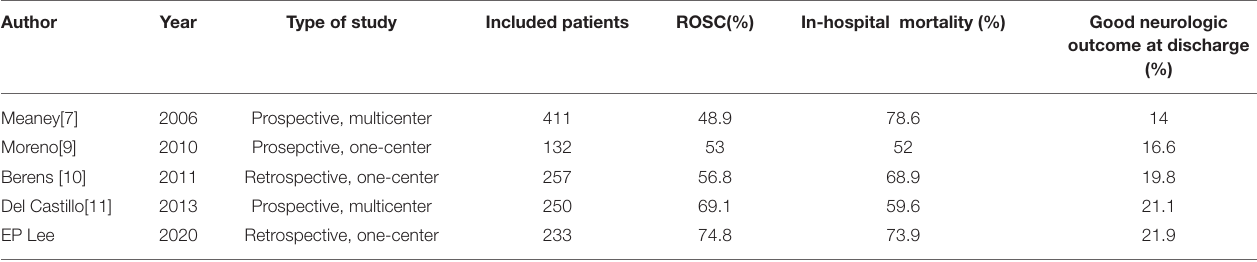
TABLE 4 | Comparison different studies about in-PCIU